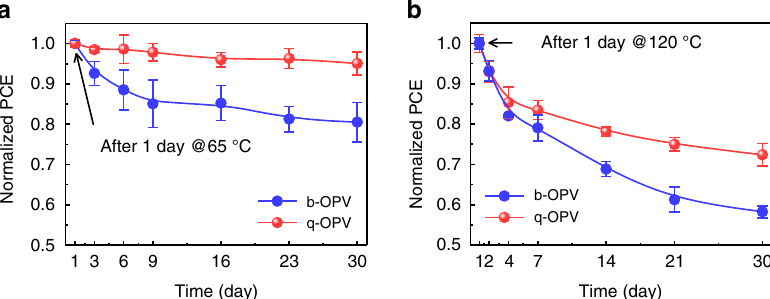
Figure 6 | Time-dependent PCE decay after burn-in loss period under thermal conditions. Time-dependent PCE of b- and q-OPVs relative to the reference PCE under the ( a ) moderate annealing temperature of 65 (cid:2) C and ( b ) harsh annealing temperature of 120 (cid:2) C for 30 days. The average values and error bars corresponding to the s.d. were obtained from more than 12 cells. NATURE COMMUNICATIONS|8:14068|DOI: